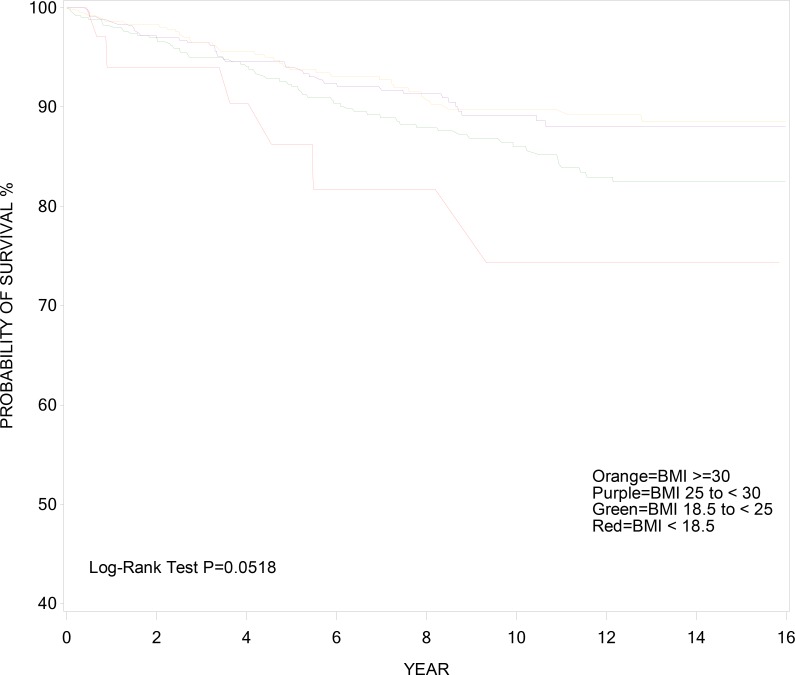
Cumulative Incidence of Non-AIDS Survival.